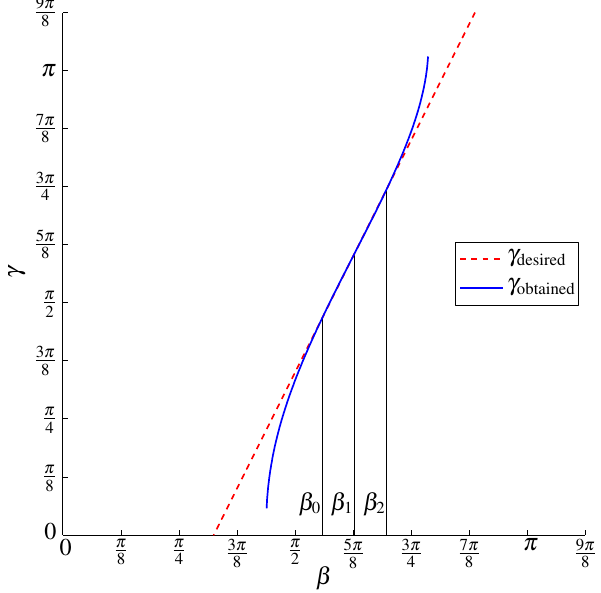
Figure 17. Angle γ desired and obtained according to β .